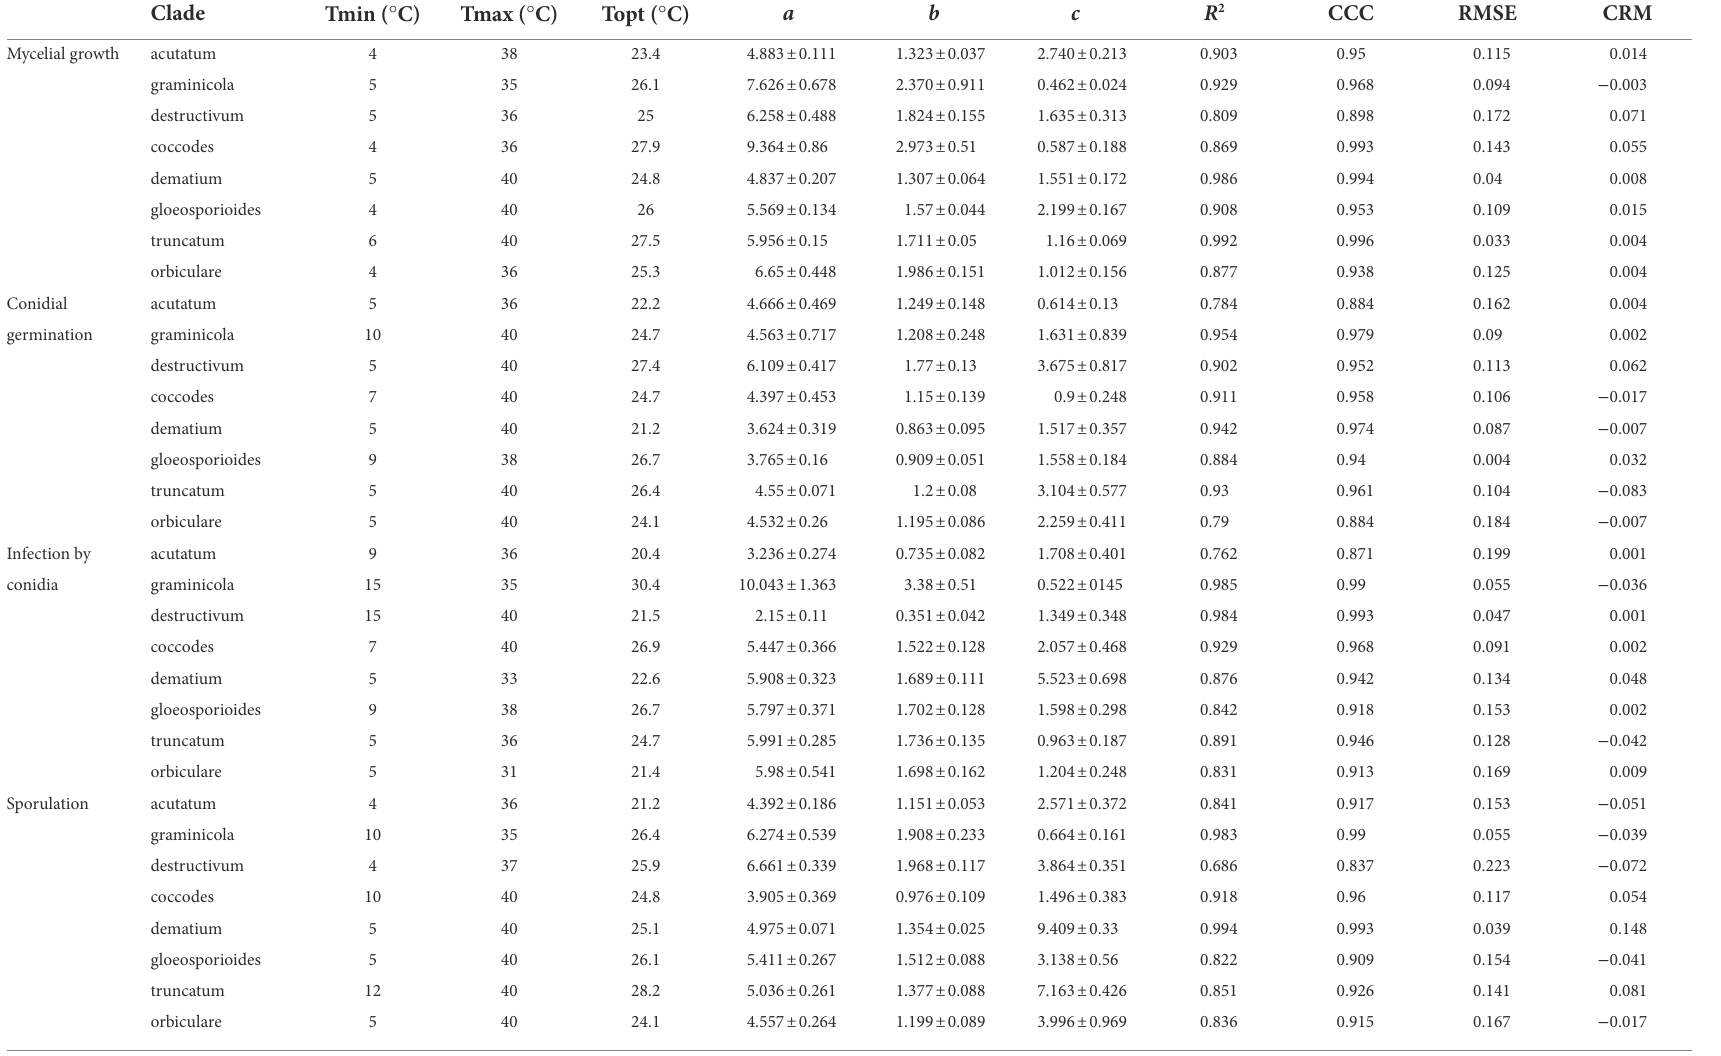
TABLE 2 Cardinal temperatures, calculated optimum temperature, estimates of parameters with their SE, and goodness-of-fit of Equation (1) for each biological process and clade.